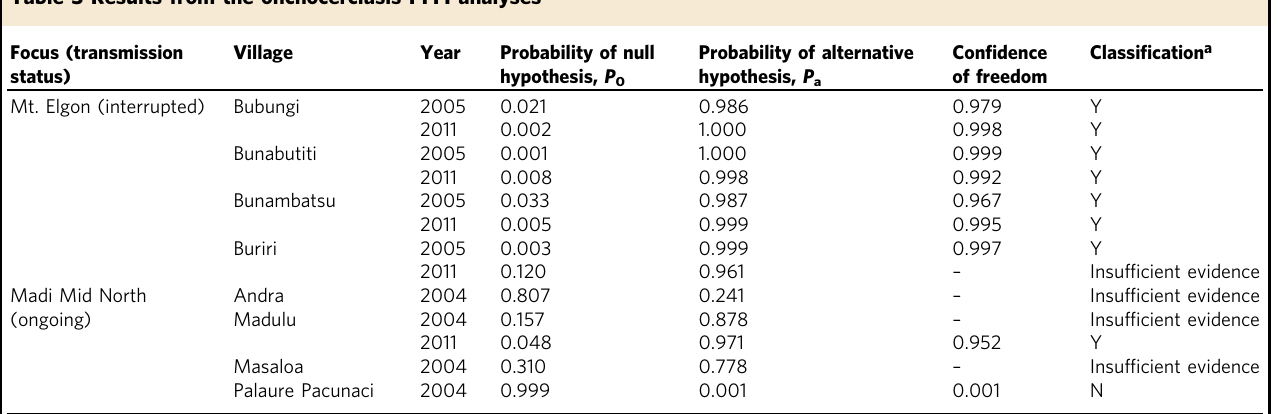
Table 3 Results from the onchocerciasis PFFI analyses Focus (transmission